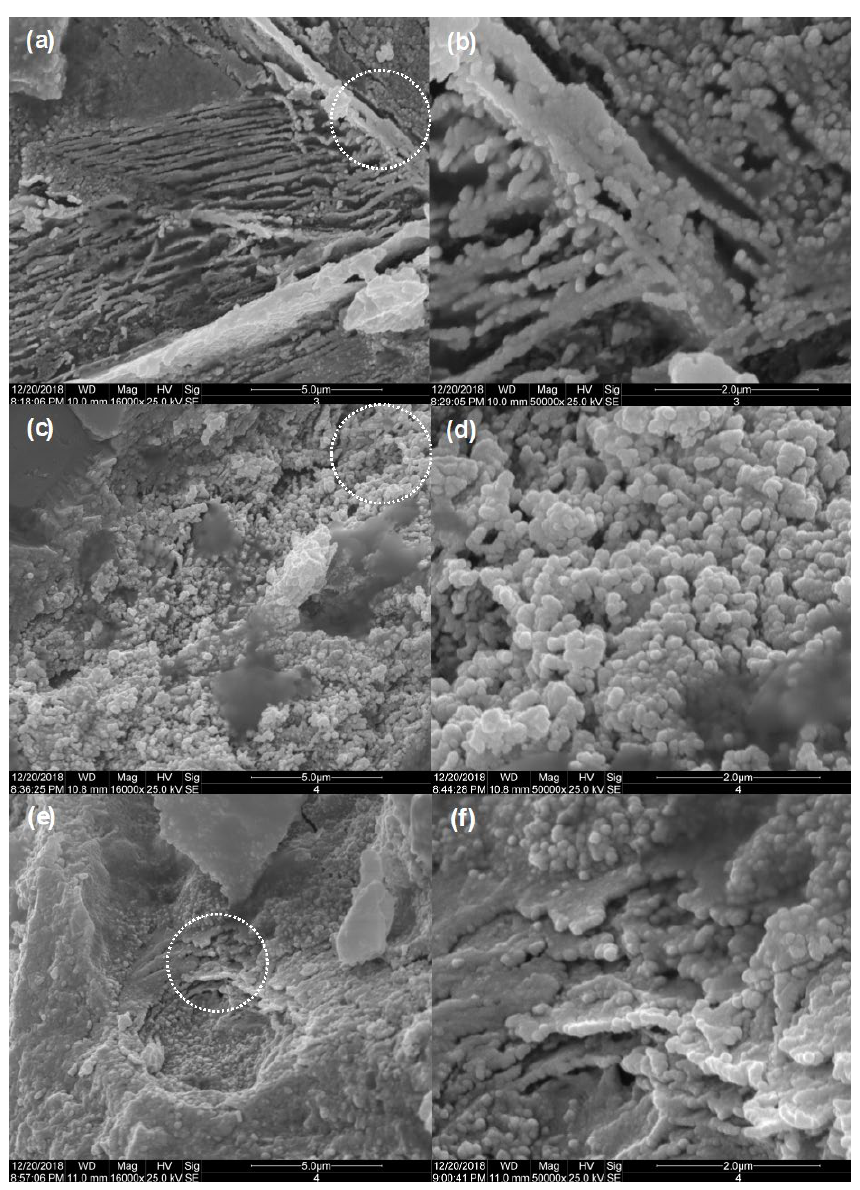
Figure 7. SEM micrographies (a, b) CPV-I + SCM + 0.85 nS (c-d) Mixture CP + SCM + 0.85